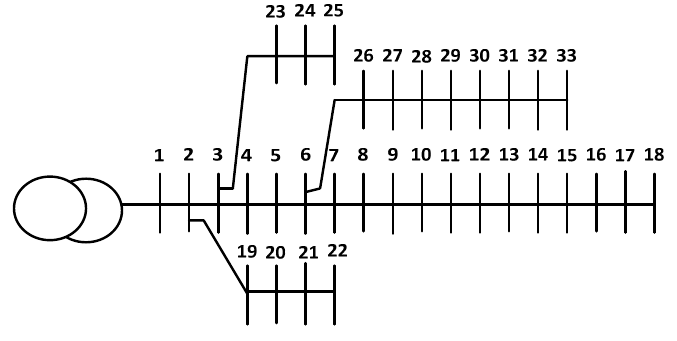
Figure 6. IEEE 33 radial distribution system.